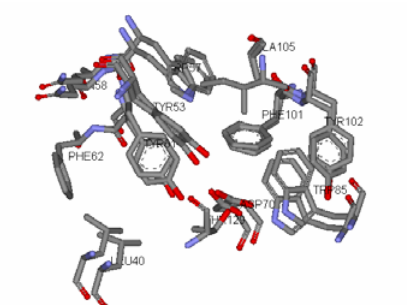
Figure. 5: Superimposed Active Site of Monomer A &